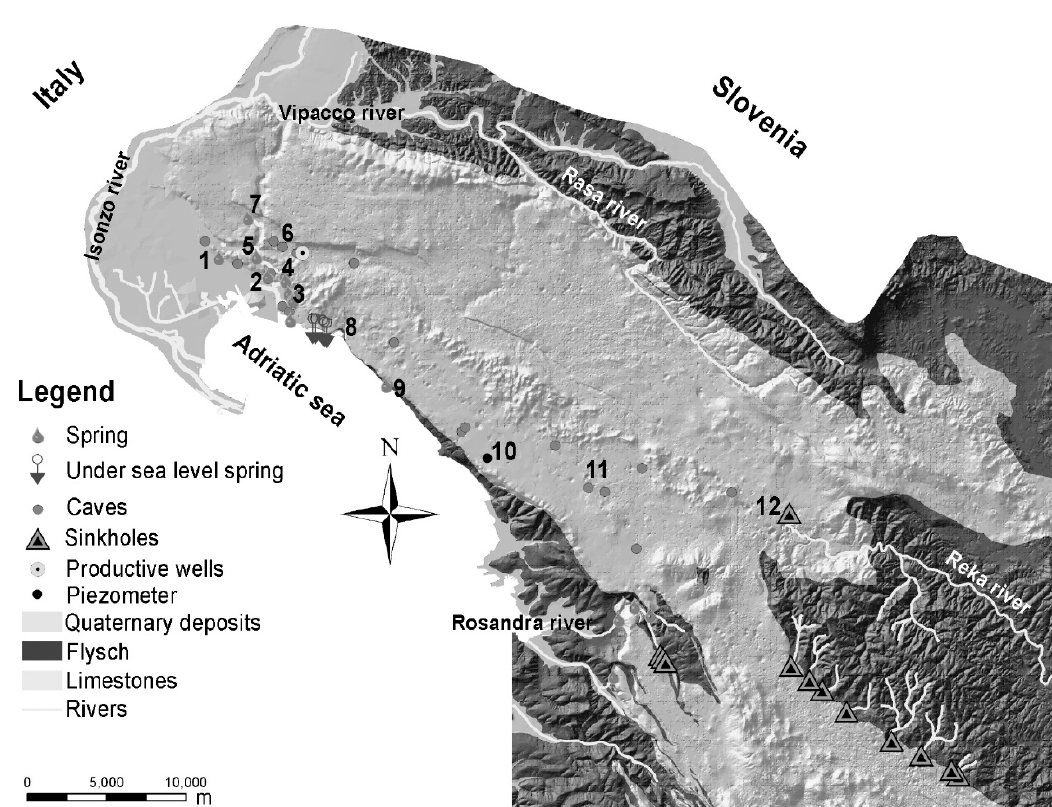
Fig. 1 Sketch of the study area. springs: 1 Monfalcone, 2 Lisert, 3 Timavo and Sardos, 4 Moschenizze, 5 Pietrarossa and Sablici, 7 Doberdò, 8 costal springs, 9 Aurisina. Caves: 6 Comarie, 11 Trebiciano, 12 Škocjan. 10 Opicina